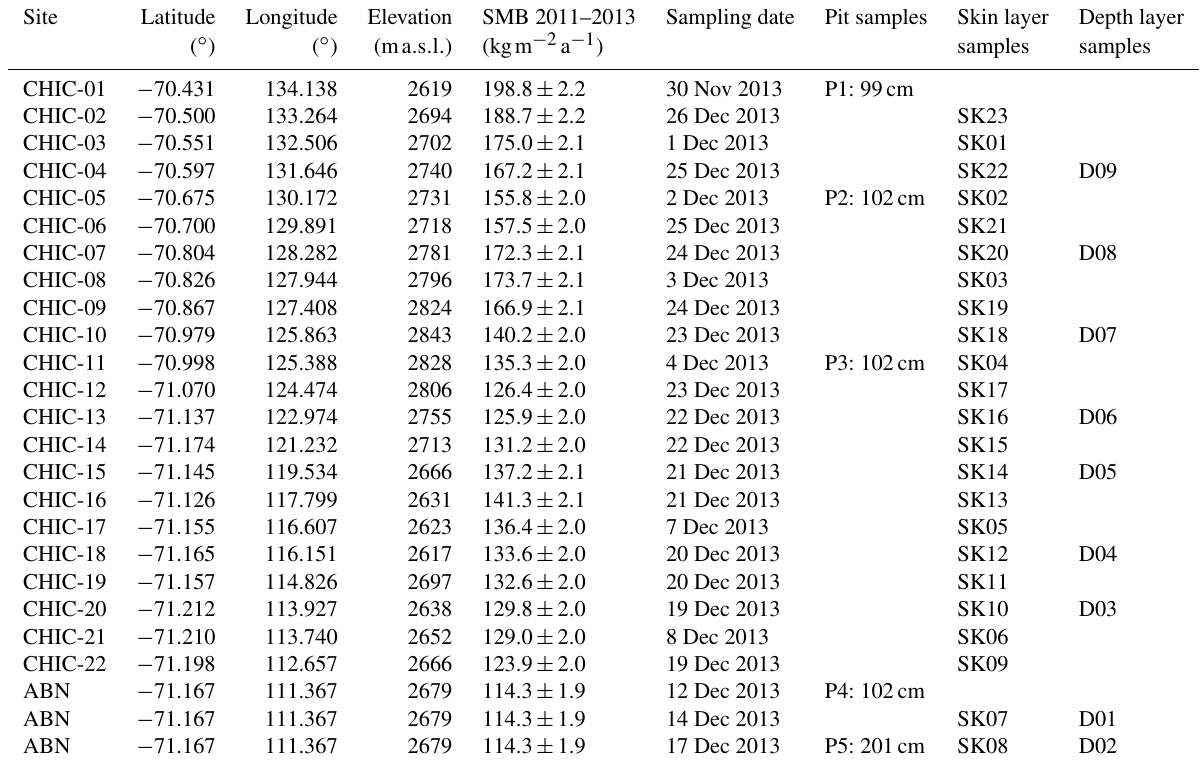
Table 1. Snow sampling site details along the CHICTABA traverse. Elevation is based on the Reference Elevation Model of Antarctica (REMA) (Howat et al., 2019), and surface mass balance (SMB) values are the mean annual SMB output and uncertainty of the MARv3.12.1 for 2011–2013 (Agosta et al., 2019; Amory et al., 2021). Sites are ordered by distance along the traverse from the D85 starting point toward the ABN (Aurora Basin North) destination. Note that the sampling dates are not sequential because samples were taken on both the outbound and return